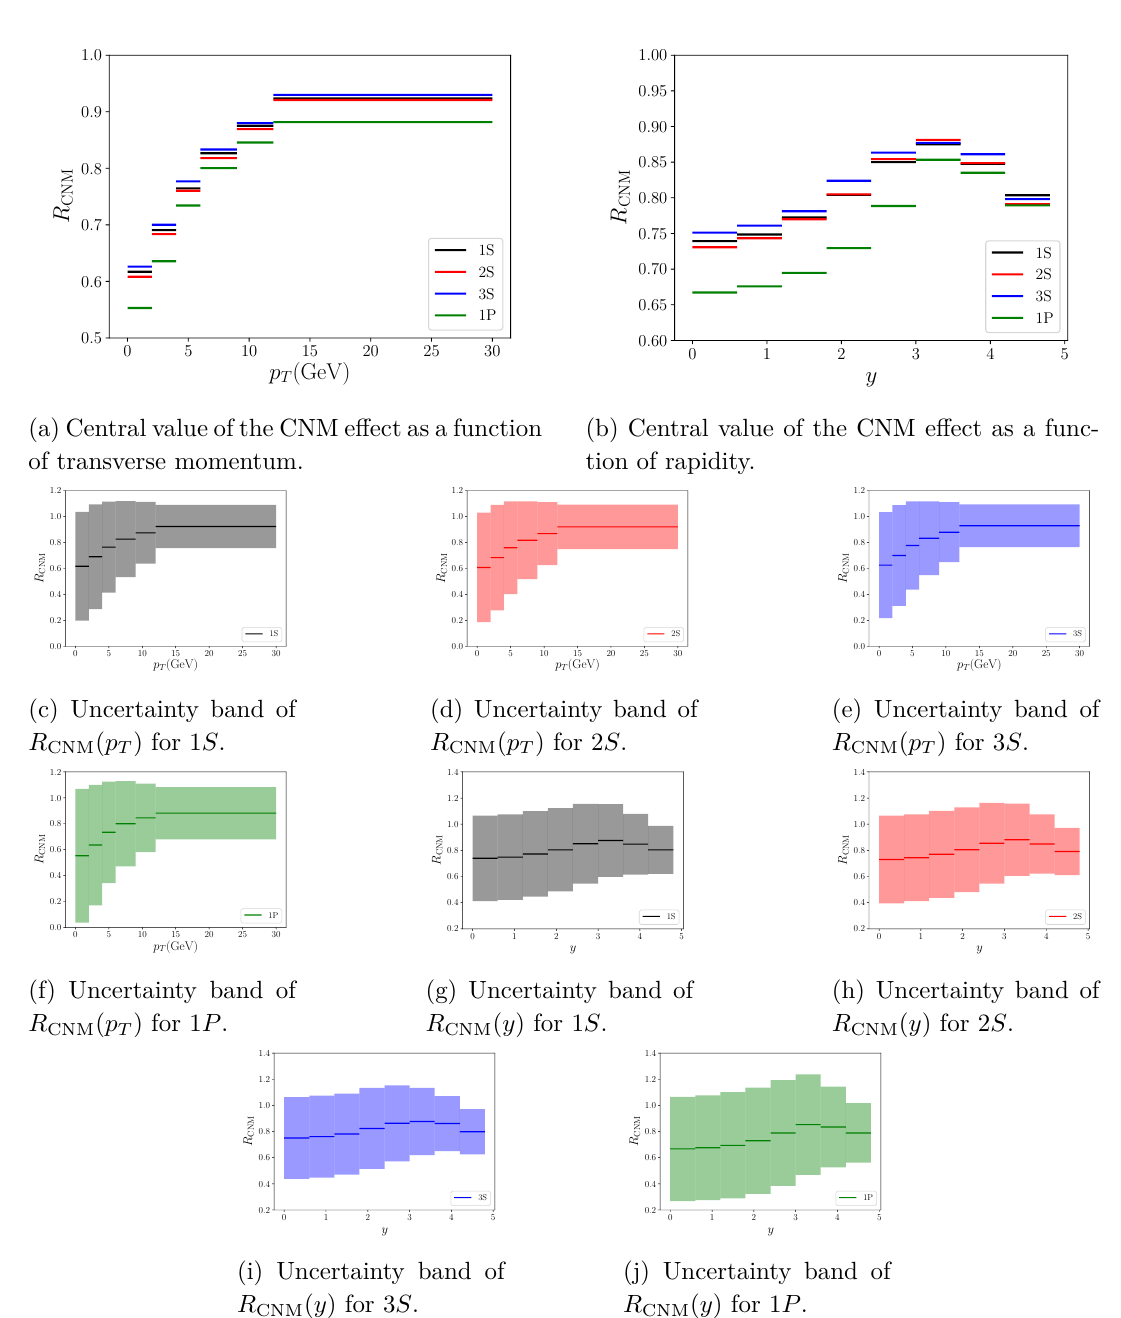
(j) Uncertainty band of R CNM ( y ) for 3 S . R CNM ( y ) for 1 P . Figure 2. CNM effects on bottomonia originated from nPDF at 5 . 02 TeV Pb-Pb collisions as functions of transverse momentum and